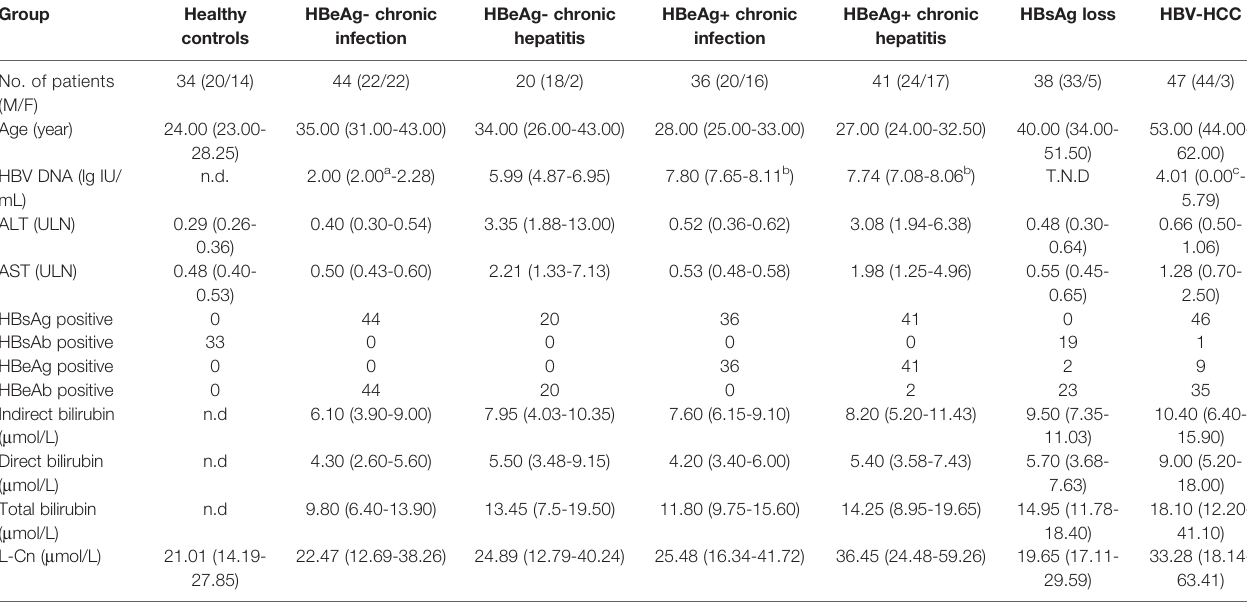
TABLE 1 | Clinical characteristics of the study